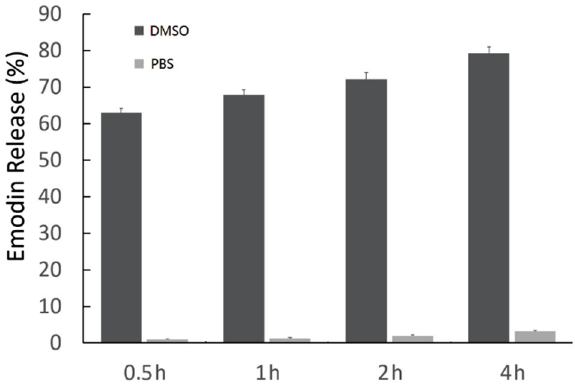
Figure 4. The amounts of emodin released from the emodin–MgSiO 3 complex measured via UV-Vis spectroscopy.